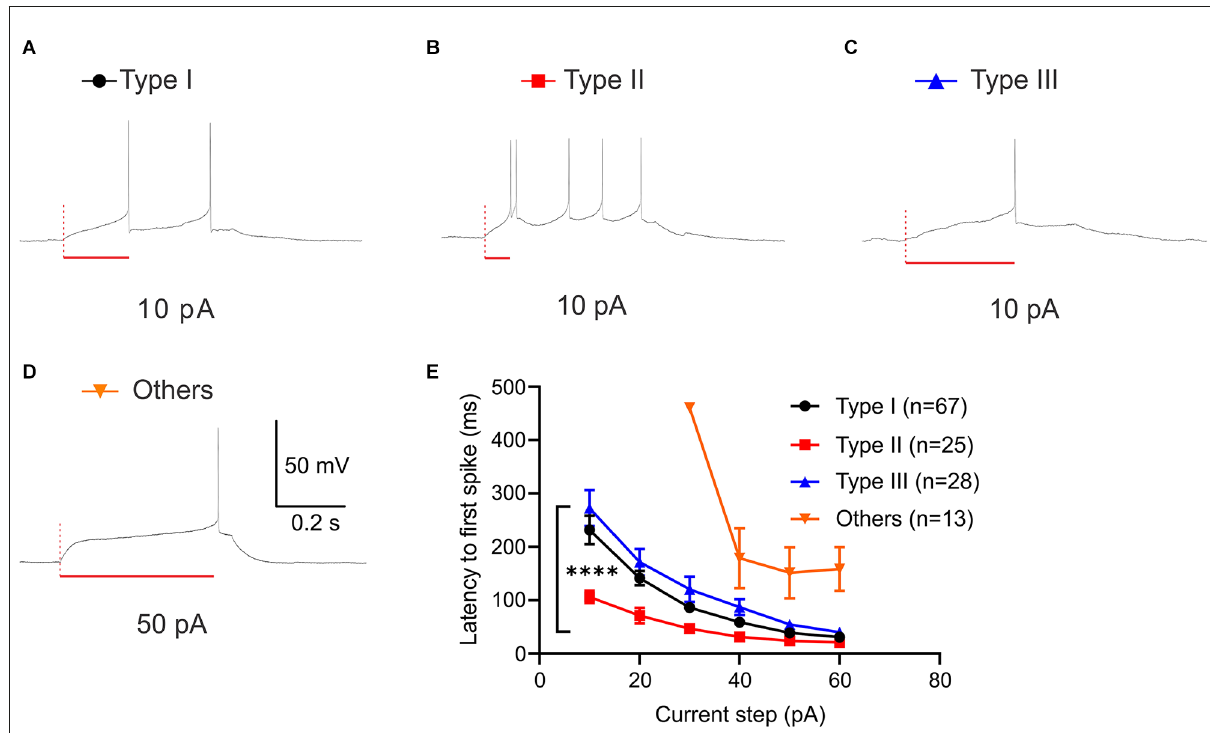
FIGURE6 First spike latency of VTA projecting BNST neurons. (A–D) Sample traces of first spike latency at 10 pA (Type I-III) and 50 pA (Type “Others”). (E) Type II neurons exhibit a shorter spike latency compared to Type I and Type III. A two-way ANOVA revealed that there was a significant interaction between the effect of neuronal types and current steps, F (10,580) = 3.967, P < 0.0001. Tukey post-hoc test revealed that Type II neurons had significantly shorter latency to first spike than Type I and Type III at +10 pA through +30 pA (adjusted P < 0.0001, vs. Type I; adjusted P < 0.0001, vs. Type III at +10 pA; adjusted P < 0.0001, vs. Type I; adjusted P < 0.0001, vs. Type III at +20 pA; adjusted P = 0.0142, vs. Type I; adjusted P < 0.0001, vs. Type III at +30 pA). ∗∗∗∗ P <